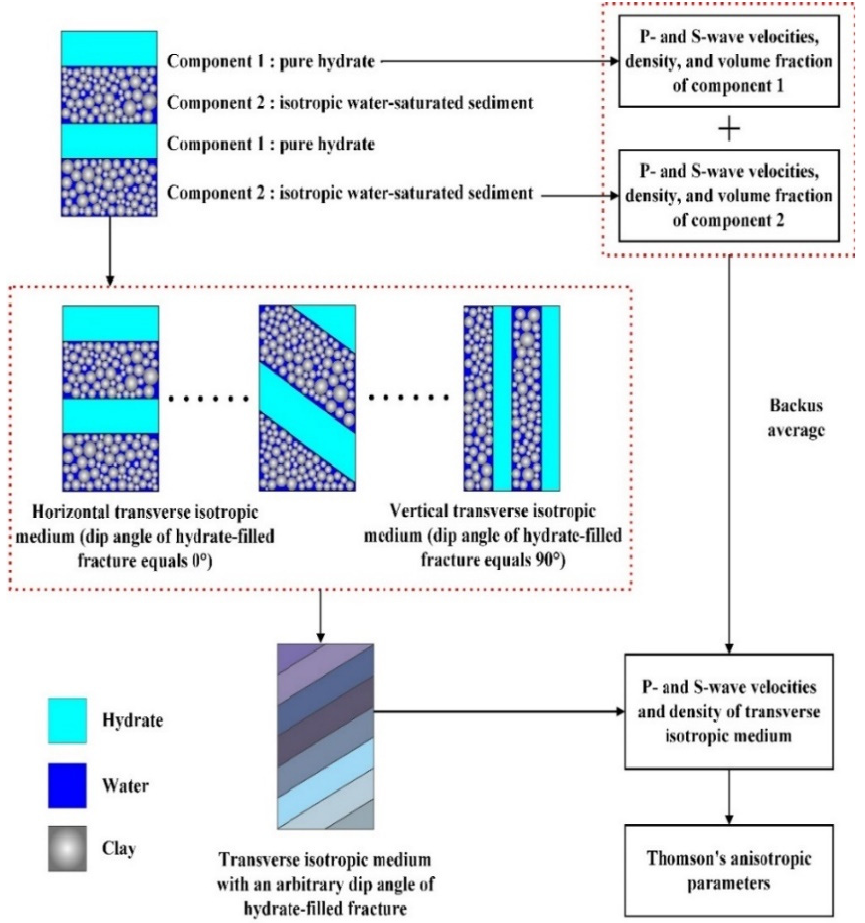
Figure 7. Workflow of the implication of the layered anisotropic model.